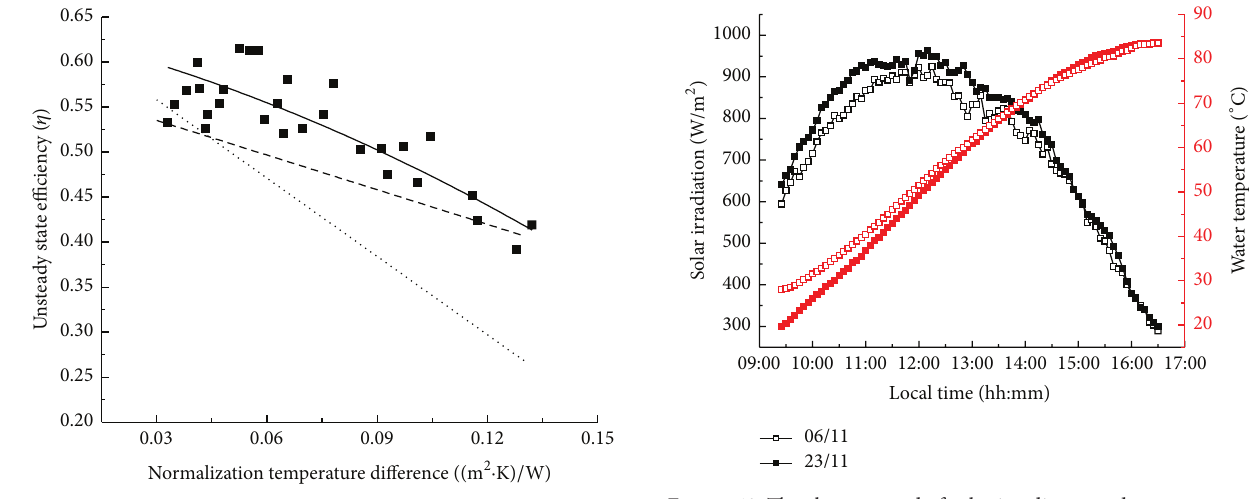
Figure 12: The change trend of solar irradiance and water tempera- ture with local